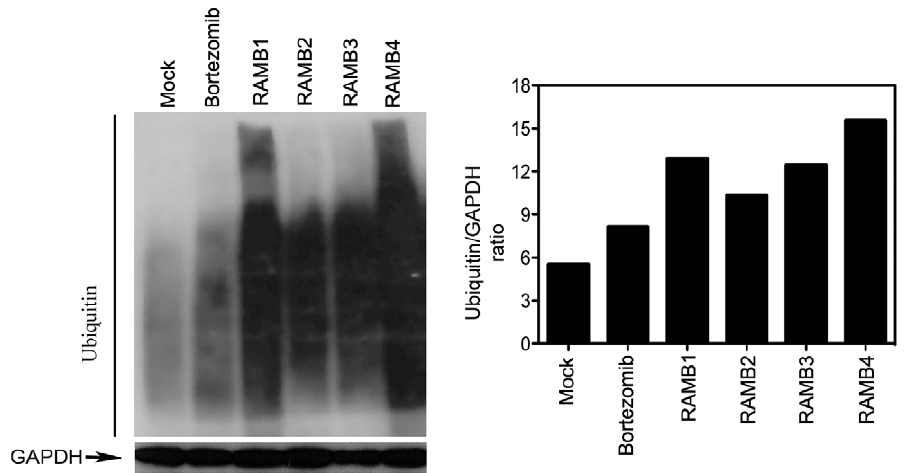
Figure 3. Effects of RAMB treatment on the levels of polyubiquitinated proteins in HeLa cells. Left panel: immunoblot analysis of ubiquitinated proteins in HeLa cells after 6 hours exposure with or without 10 m M RAMBs. Bortezomib was used as positive control. Equal protein loading in each lane was verified by using an antibody against GAPDH. Right panel: Quantification of the Ubiquitin/GAPDH ratios.